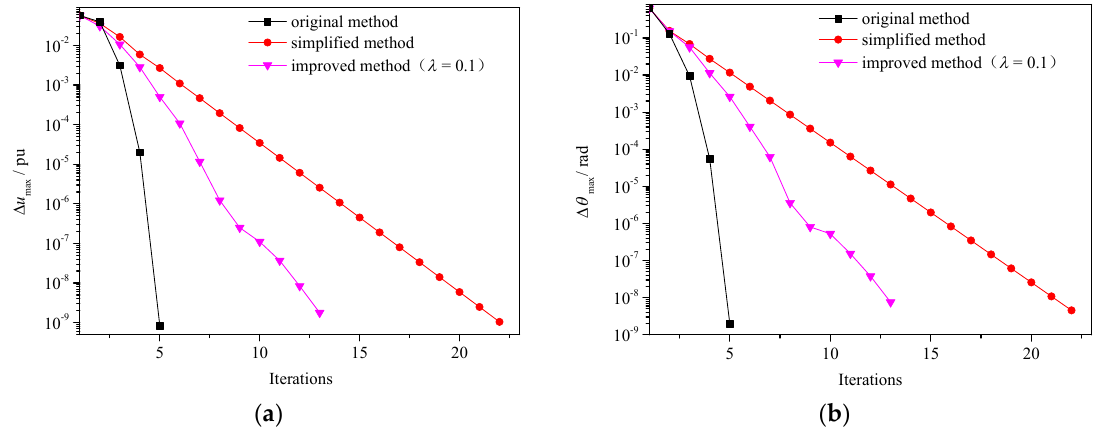
Figure 6. The iteration process of the three methods when P c is − 150 MW. ( a ) The largest voltage magnitude change; ( b ) the largest voltage phase angle change.